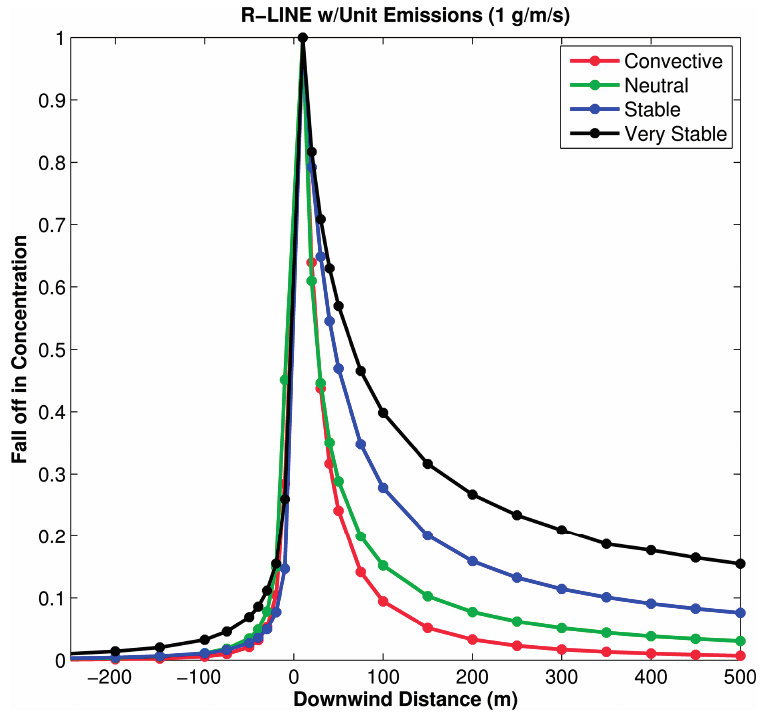
Figure 5. R-LINE concentration gradients for the representative meteorological conditions in Table 6. All concentrations are normalized by the estimated concentration closest to the